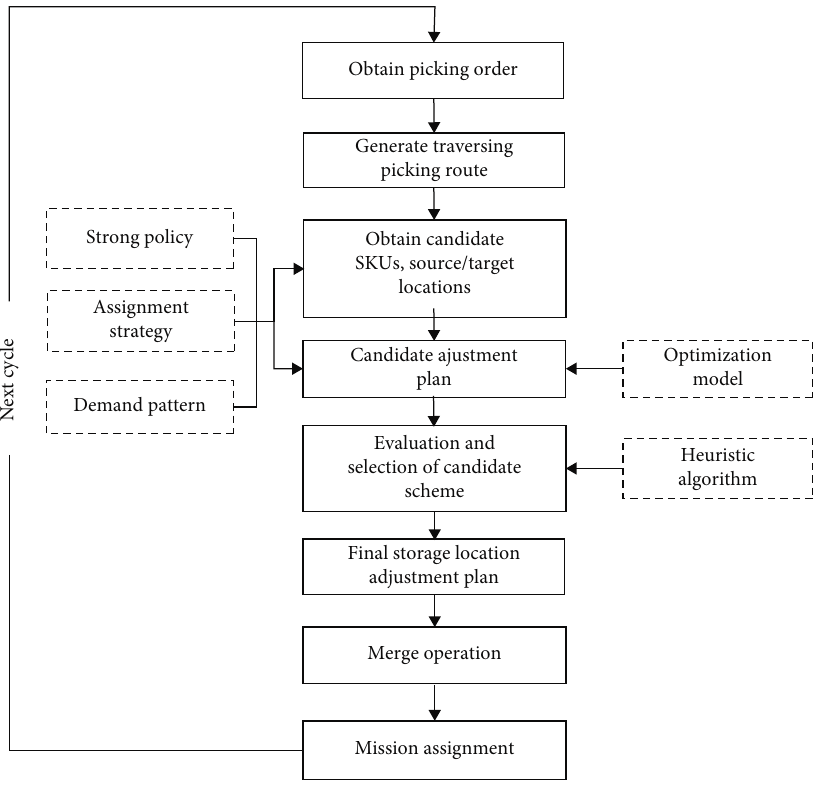
Figure 1: Model of